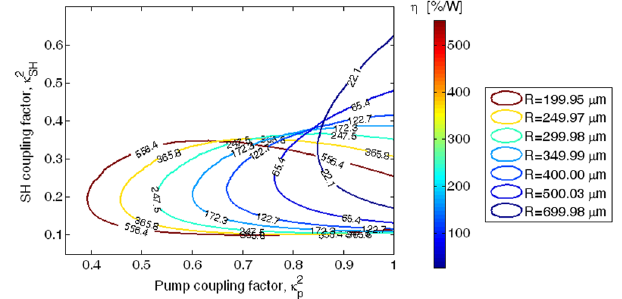
Figure 7. Contour curves at 90% of maximum value of the efficiency η as a function of the pump and SH coupling factors, for different values of MRR radius.